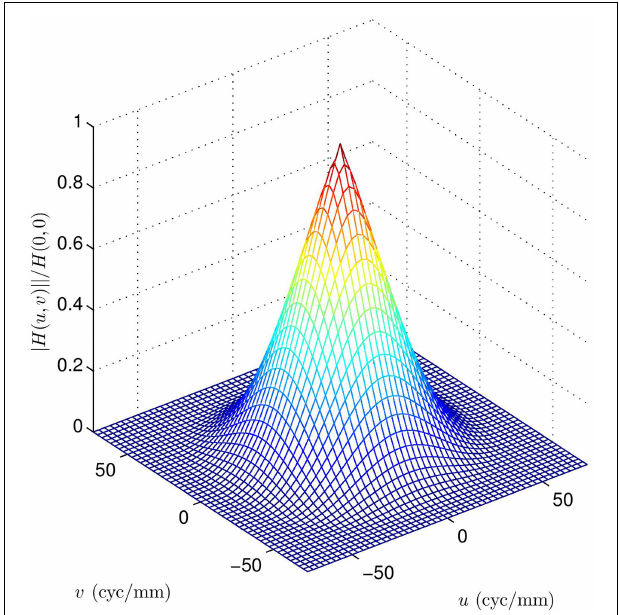
FIGURE 12 | Overall system MTF for the diffraction OTF in Figure 3 ( F = 3 . 33 , λ = 4 . 5 μ m), and a square detector MTF with a = 15 μ m (i.e., 25% fill factor). Note the zero from the detector does not impact the overall MTF within the spatial frequency passband of the optics.